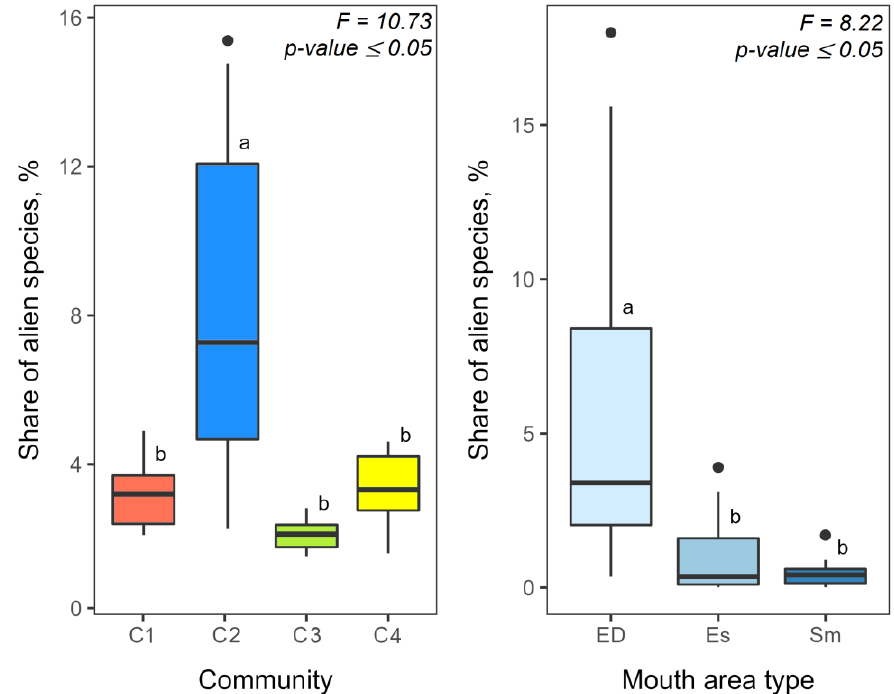
Figure 6. Boxplots of the alien species’ shares in different zooplankton communities and different mouth-area types (for zooplankton community 2): estuary–deltaic mouth areas (ED), estuarine mouth areas (Es), and simple mouth areas (Sm). Compact letter displays were added to indicate significant differences. С olour coding is shown in Figure 2.